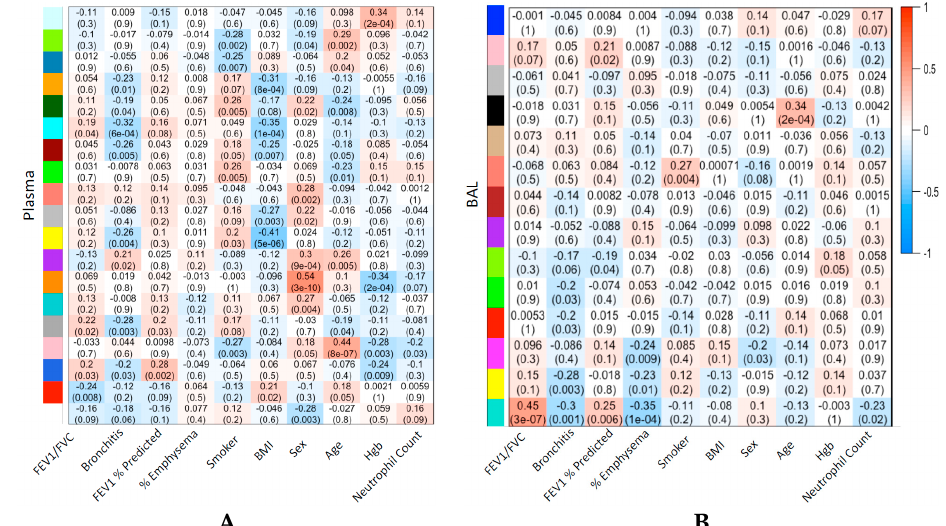
Figure 4. Strength of correlation between weighted gene co-expression network analysis (WGCNA) modules and clinical variables and outcomes. Heatmap of module/clinical variable correlation. Plasma ( A ) or BAL ( B ). Module colors correspond to dendrogram in Supplemental Figure 2. Cell text is Pearson correlation ( P -value) between the first principal component representing the module and the corresponding variable. Plasma WGCNA modules without any correlation, p -values < 0.01, are excluded (12 excluded, 19 displayed) for greater visual clarity. Full plasma WGCNA module to clinical variable correlations are shown in Supplemental Figure 5.